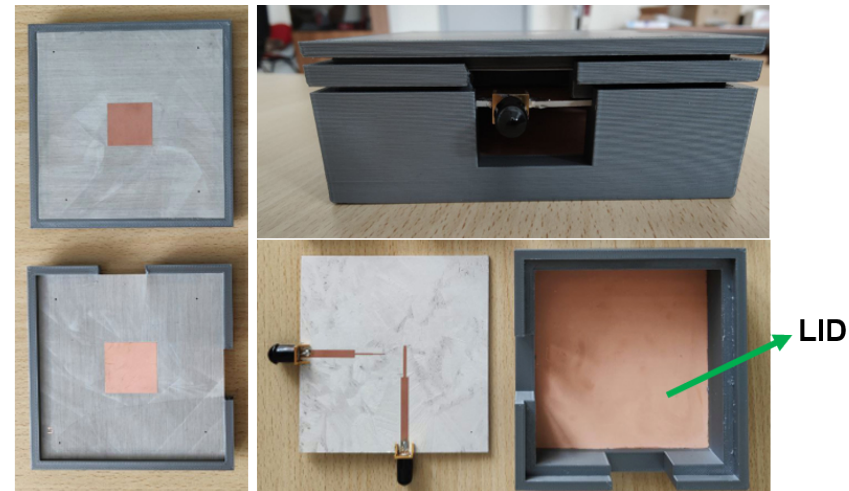
Figure 7. Different view of realized prototype.